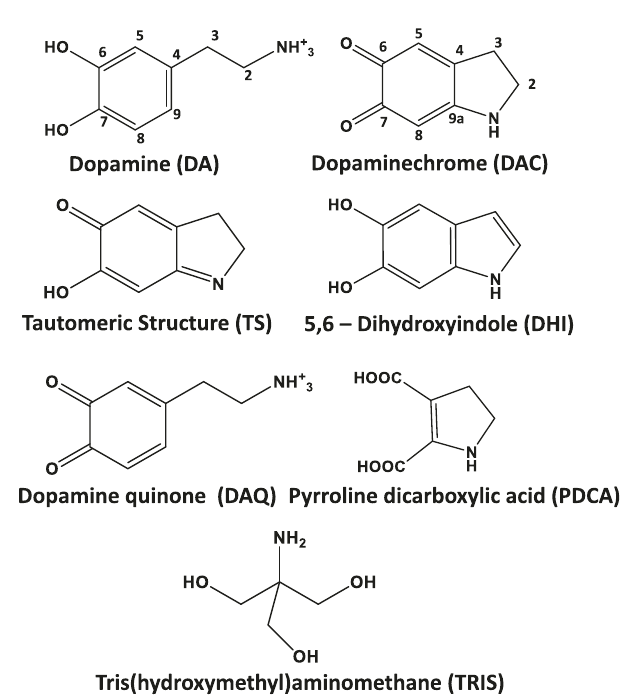
Fig. 4 | Building blocks of polydopamine. Chemical structures of the expected building blocks of polydopamine. DA and DAQ are shown in their positively charged protonated states, the expected major species in the employed solution